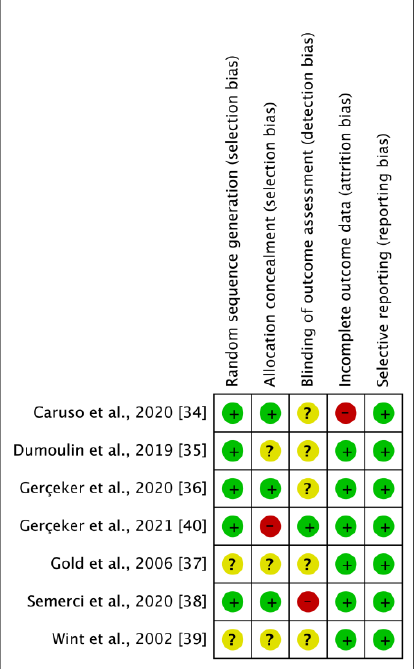
Figure 2. Risk of bias summary. + (green): low risk; ? (yellow): unclear risk; − (red): high risk.